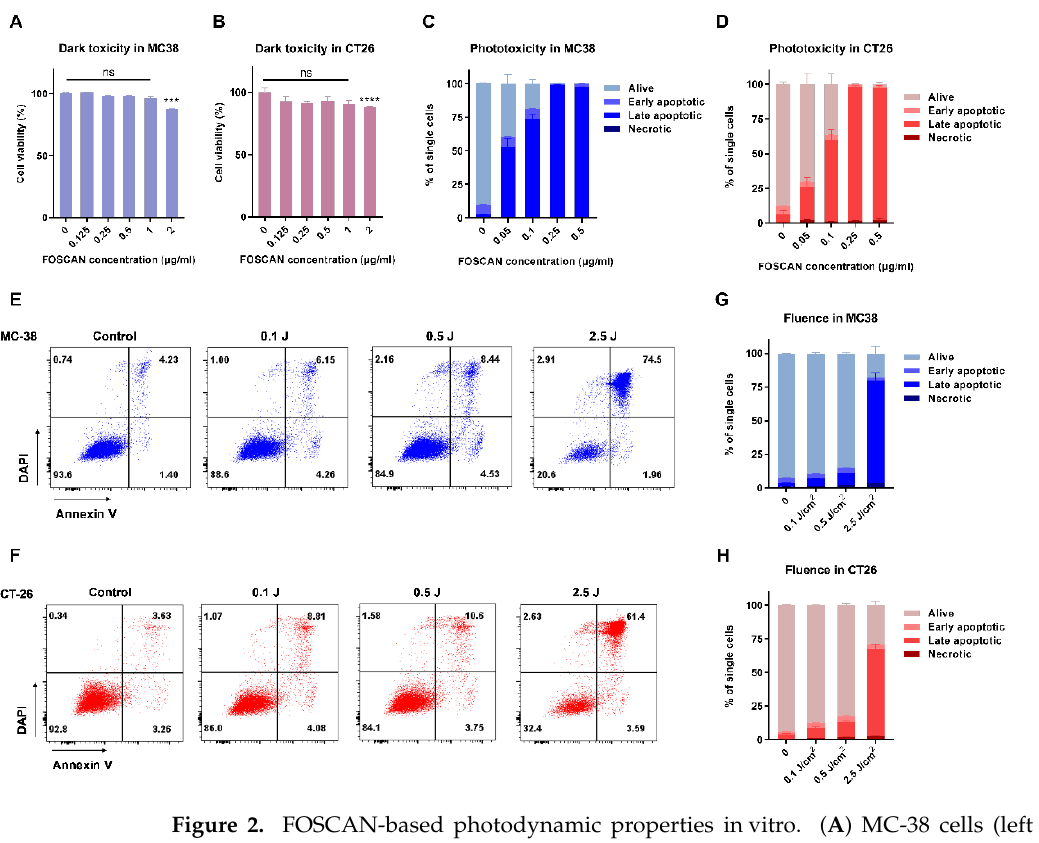
Figure 2. FOSCAN-based photodynamic properties in vitro. ( A ) MC-38 cells (left panel) and ( B ) CT-26 cells (right panel) were incubated with various concentrations of FOSCAN for 24 h, followed by washing and incubation for another 24 h. The next day, MTS assays were performed to determine FOSCAN toxicity without light using a spectrum analyzer. Results were compared by an unpaired Student’s t -test and the statistical differences are denoted as ns: not significant, *** p < 0.001 and **** p < 0.0001. The effect of the FOSCAN concentration in MC-38 cells ( C ), and CT-26 ( D ); the effect of fluence in MC-38 cells ( E , G ) and CT-26 cells ( F , H ), on the FOSCAN-mediated PDT effects in vitro were investigated by flow cytometry analysis. Cells were incubated with 0.2 µg/mL FOSCAN for 24 h, followed by PDT and incubation for another 24 h. The next day, flow cytometry analyses were performed to determine the apoptosis after double staining with Annexin V-FITC and DAPI. All graphs show the mean values ± SEM from three independent experiments.